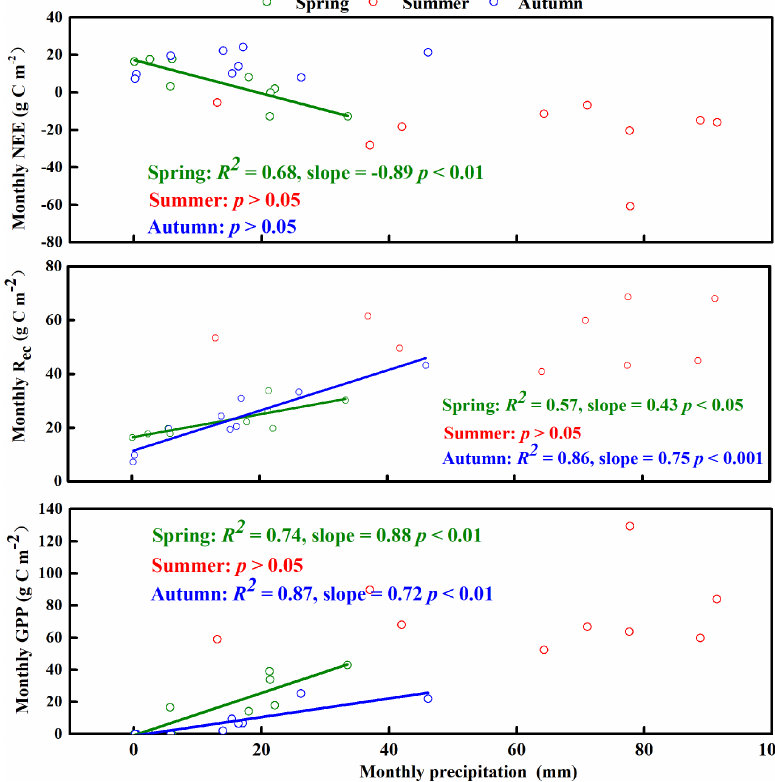
Figure 7. Relationship between monthly net ecosystem carbon exchange (NEE), gross primary productivity (GPP), and ecosystem respiration ( R ec ) and the corresponding monthly precipitation in the spring (March–April–May), summer (June–July–August), and autumn (September–